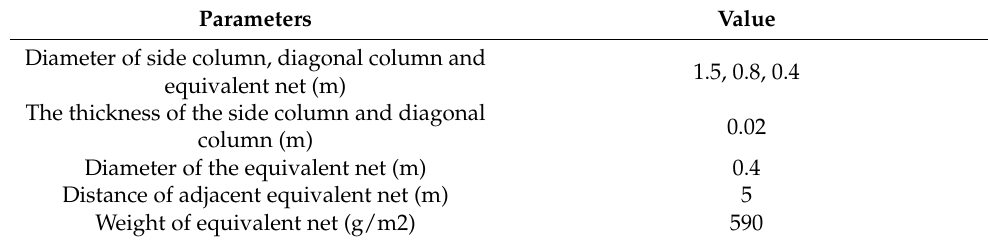
Table 3. Main parameters of the aquaculture cage.